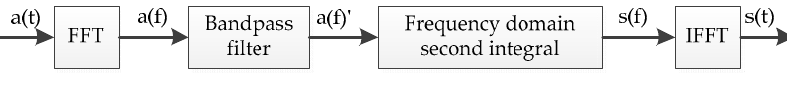
Figure 2. Flow field based on frequency domain bandpass process.